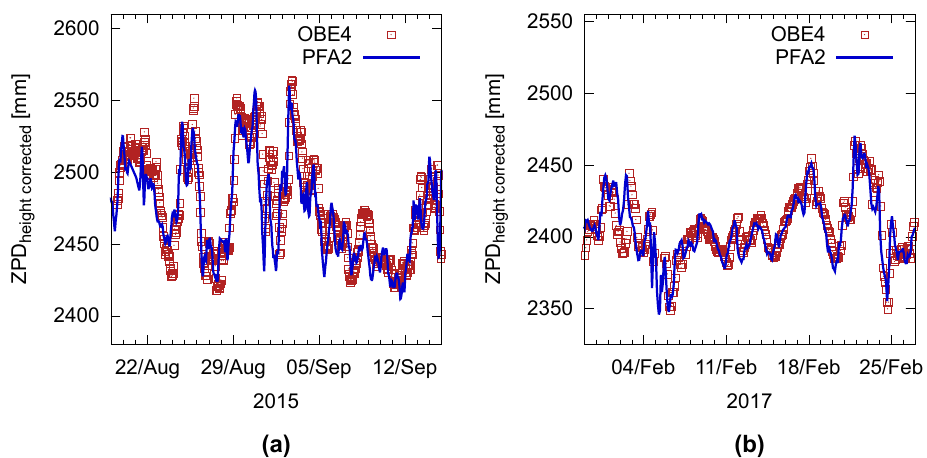
Figure 5. Height corrected zenith path delay from the permanent GNSS network EUREF for two stations (OBE4: Oberpfaffenhofen, Germany; PFA2: Bregenz, Austria) nearby the DLR calibration